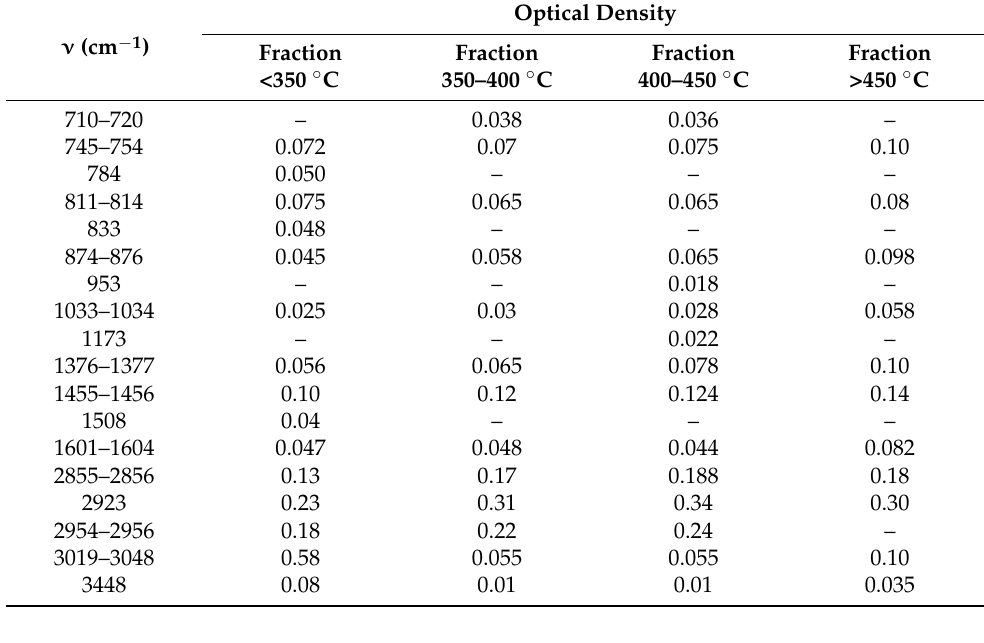
Table 5. IR spectral features of the gasoil fractions.